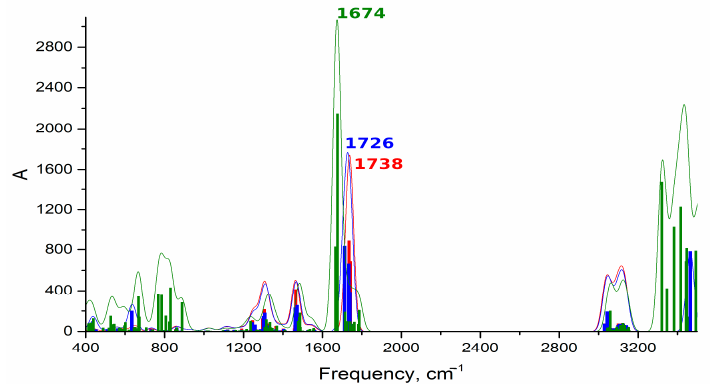
Figure 9. Simulated spectra of the VP-VP-VP moiety of the copolymer with n = 0, 1 and 8 water molecules respectively red, blue and green colors.